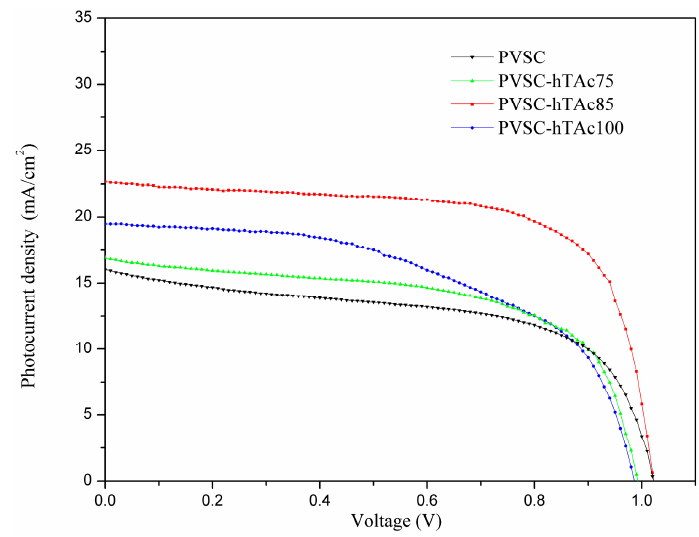
Figure 4. Photocurrent density-voltage curves of PVSCs incorporating various h-TAc amounts in the active layer.